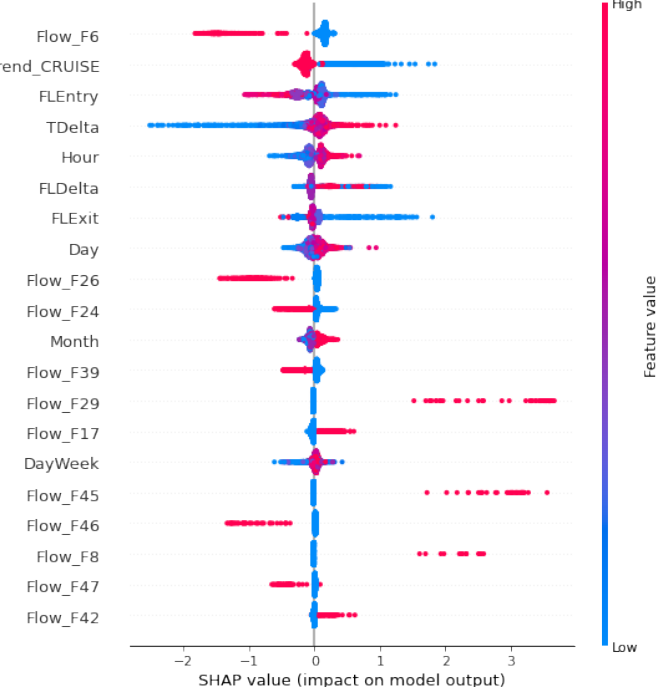
Figure 14. SHAP values of the classification model for Sector